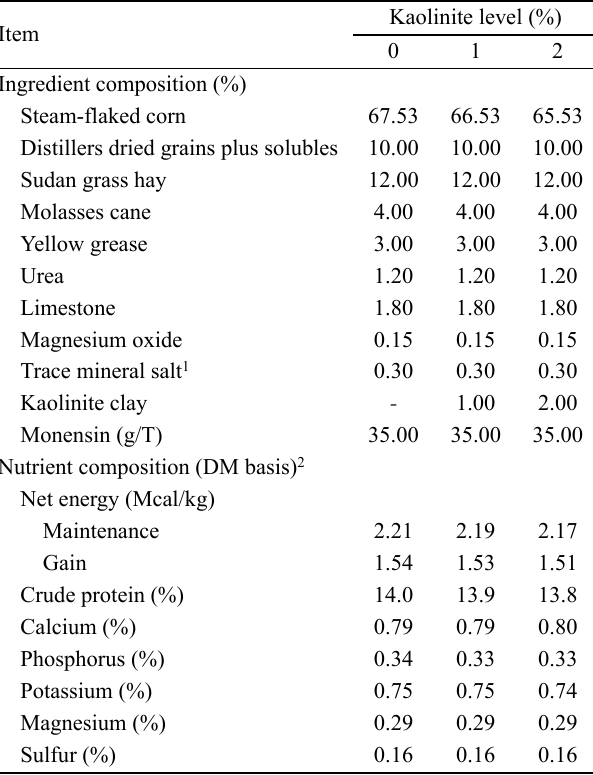
Table 1. Composition of experimental diets fed to steers